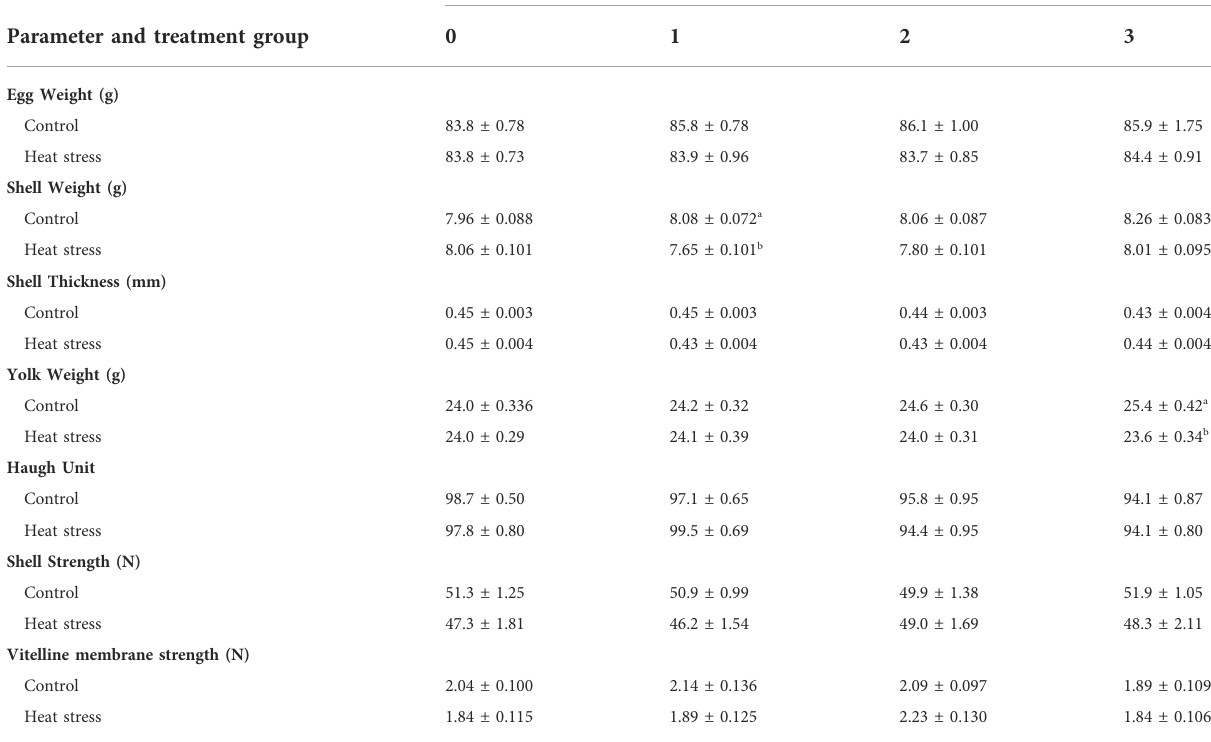
TABLE 2 Effect a of a 3-week chronic cyclic heat stress b on egg quality parameters c of breeder